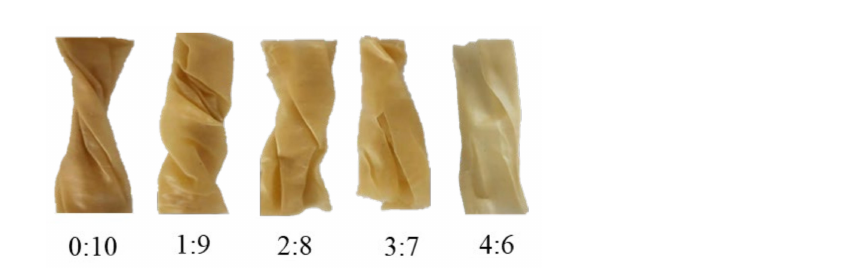
Figure 2. Appearances images of extrudates with different surimi to soybean flour ratio.